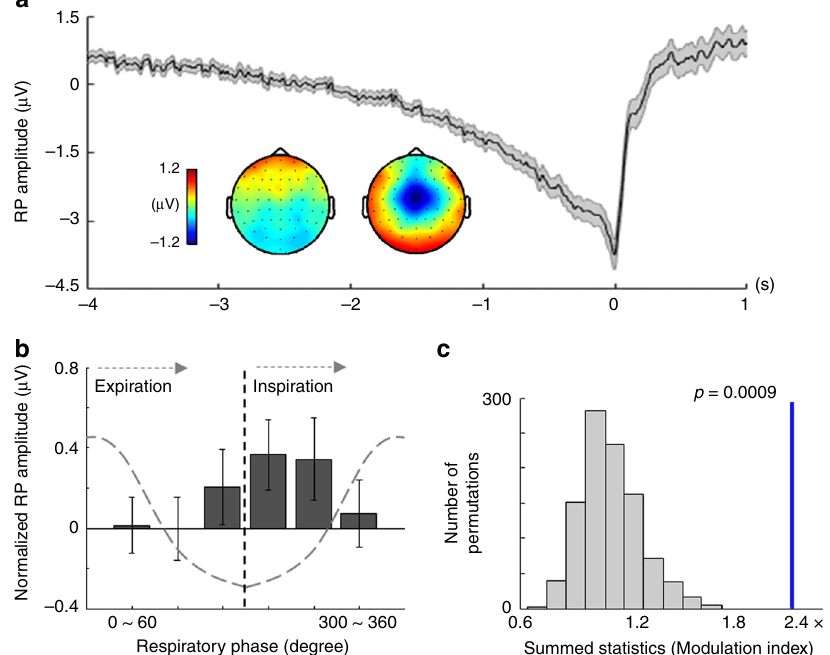
Fig. 3 Coupling between the respiratory phase and the readiness potential (RP) amplitude. a RP waveform obtained from fronto-central electrodes ( n = 52). Gray shaded area represents the s.e.m. Inserted topographies were respectively obtained from the time windows ( − 4 ∼ − 2 s; left) and ( − 2 ∼ 0 s; right). b The amplitude of RP as a function of six equally sized bins of the respiratory phase is shown. Error bars represent the s.e.m. c Histogram of the summed statistics (i.e., Modulation index; MI) obtained from surrogate respiration data whose phase is randomly shifted. The blue vertical line indicates the summed statistics from original respiration data. The result of the permutation test con fi rms that the original MI is signi fi cantly larger than chance-level MIs obtained from surrogate respiration data (permutation p = (Supplementary Fig. 3) 25 , rather than the Hilbert transform (see Methods). In Experiment 1, the distribution of cardiac phases at the timing of button press was not non-uniform (Supplementary Fig. 4; Hodges – Ajne test for all the button presses across 20 participants, p = 0.80, M = 1262; Hodges – Ajne test for mean values across 20 participants, p = 0.59, M = 6). There was no signi fi cant association between the cardiac phase and button press in Experiment 2 (Libet task, Supplementary Fig. 5a; Hodges – Ajne test for all the button presses across 31 participants, p = 0.24, M = 1106; Hodges – Ajne test for mean values across 31 participants, p = 0.71, M = 11) nor in Experiment 3 (externally triggered action task, Supplementary Fig. 5b; Hodges – Ajne test for all the button presses across 31 participants, p = 0.78, M = 1125; Hodges – Ajne test for mean values across 31 participants, p = 0.92, M = 12). These results indicate participants ’ button presses were not associated with the cardiac phase.